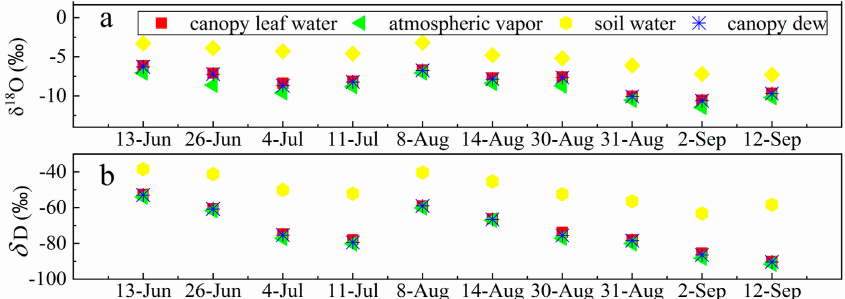
Figure 4. Seasonal variability of δ D and δ 18 O in di ff erent waters by type from di ff erent heights (2017): ( a ) Seasonal variability of δ 18 O in canopy leaf water, atmospheric vapor, soil water and canopy dew; ( b ) Seasonal variability of δ D in canopy leaf water, atmospheric vapor, soil water, and canopy